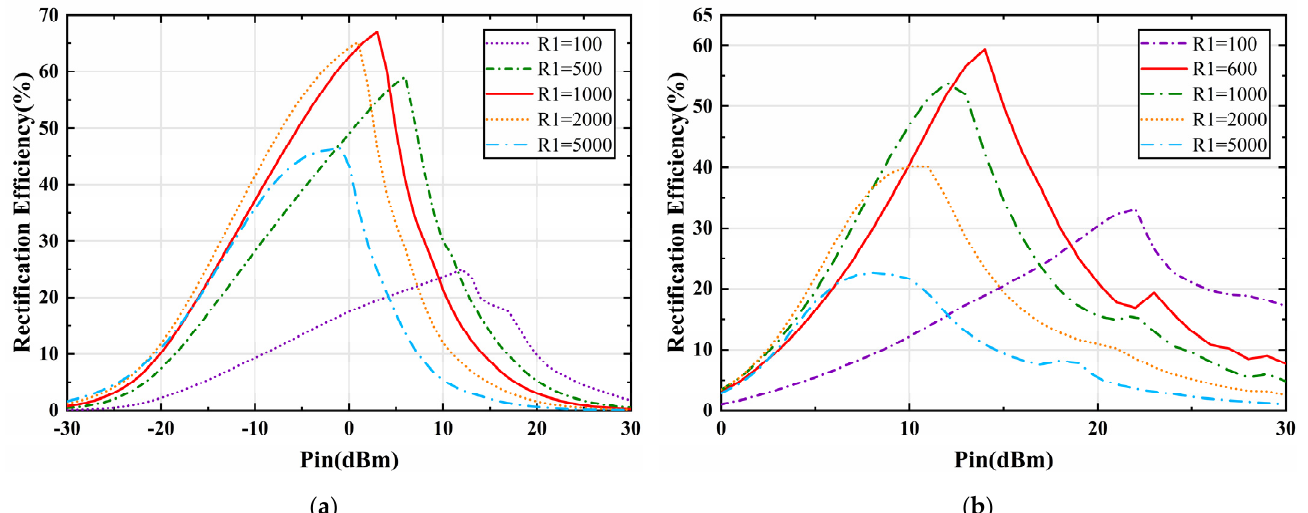
( b ) Figure 8. Simulated rectification efficiency curves versus frequency for ( a ) the single series diode rectifier and ( b ) the voltage doubler rectifier at different input power levels. Furthermore, the variation of rectification efficiency versus input power and load re- sistance is analyzed as shown in Figure 9a,b. It can be noticed that the rectification effi- ciency grows with the increase of input power at both 2.4 GHz and 12.6 GHz and reaches the maximum at 3 dBm and 14 dBm, respectively. In this case, the efficiency reaches the maximum at 2.4 GHz and 12.6 GHz for load resistors RL with values of 1000 Ω and 600 Ω , respectively. The variation curve shown in Figure 9 well illustrates the nonlinearity of the rectifier diode against the input power and load resistance, which is directly related to whether the rectifier can be well matched. Finally, the rectification efficiency versus